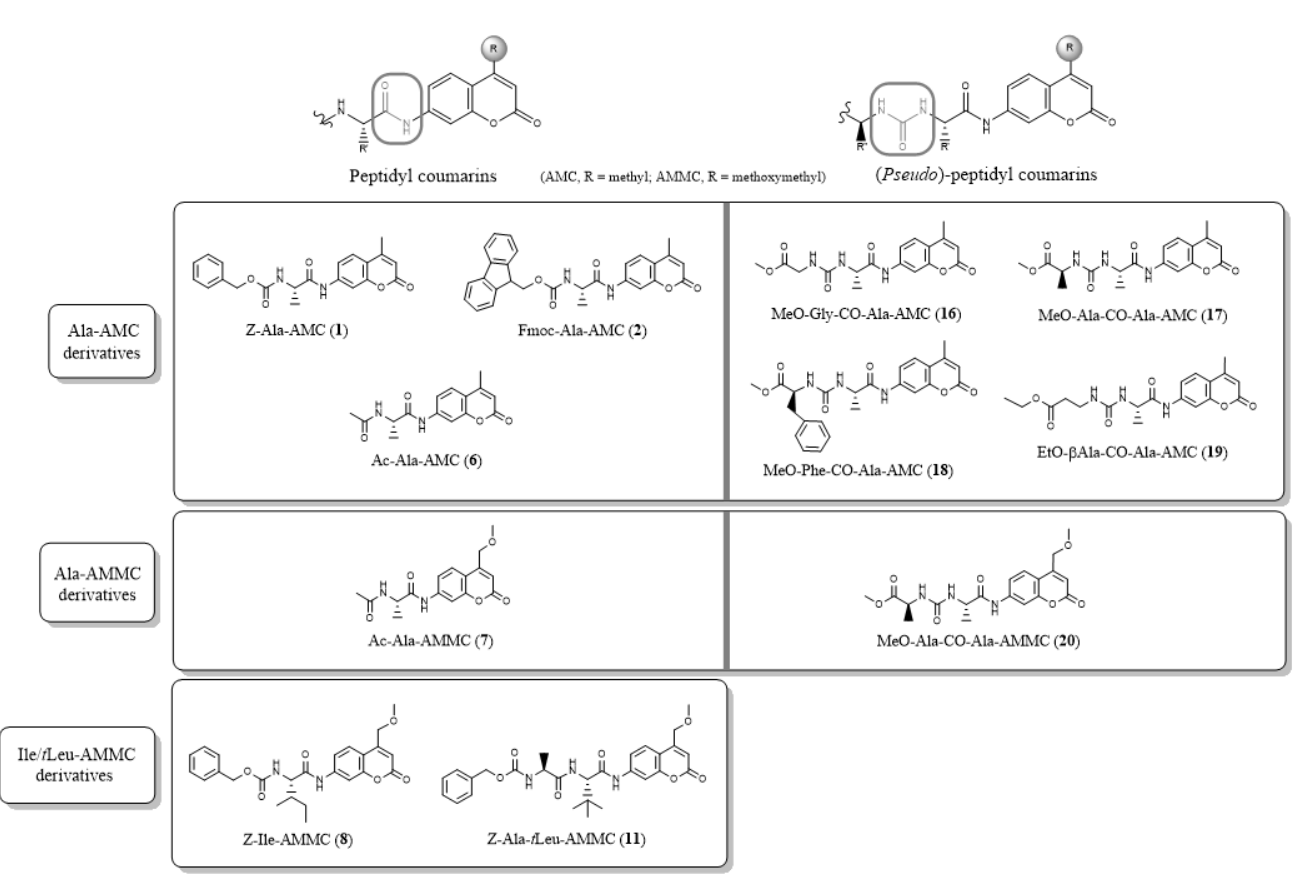
Figure 1. Amino acyl (compounds 1 , 2 , 6 – 8 ) and ( pseudo )-dipeptidyl ( 11 , 16 – 20 ) derivatives of 4-methyl (AMC)- and 4-methoxymethyl (AMMC)-substituted 7-amino-coumarins.